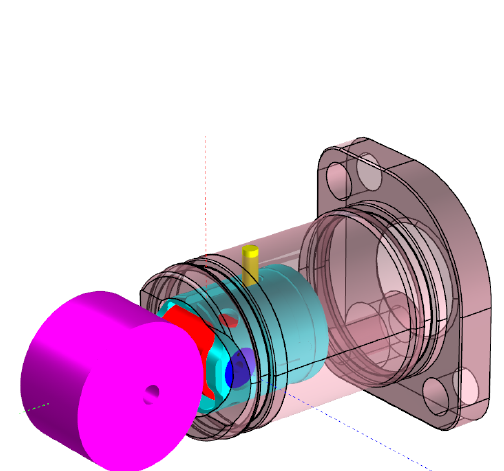
Figure 1: A cam follower unit model. It has nine conformal contacts and one concentrated contact.